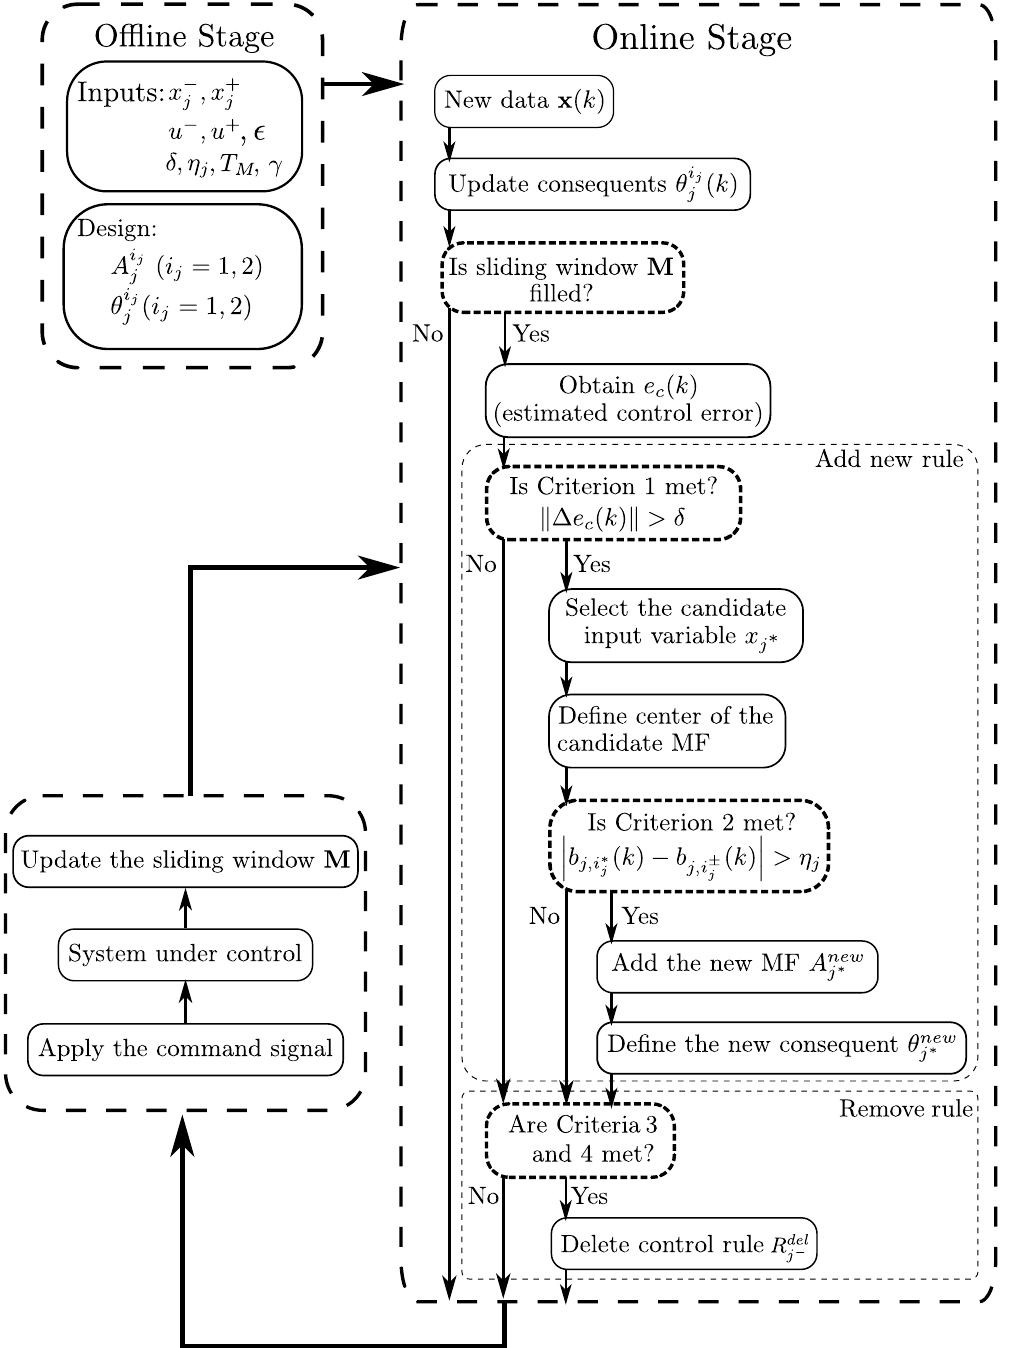
Figure 3. Flowchart of the proposed self-evolving FLC design